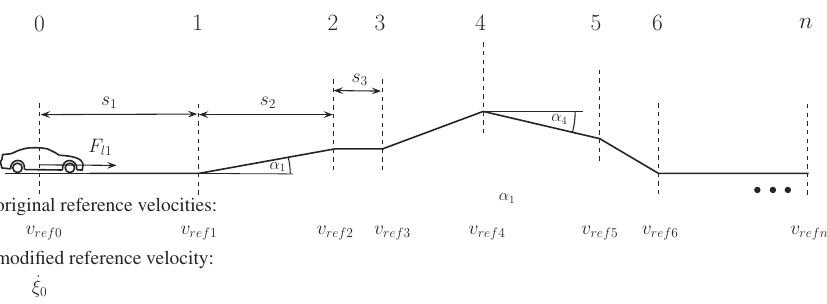
Figure 2, the look-ahead distance L is divided into n number of road sections with n + 1 number of points.